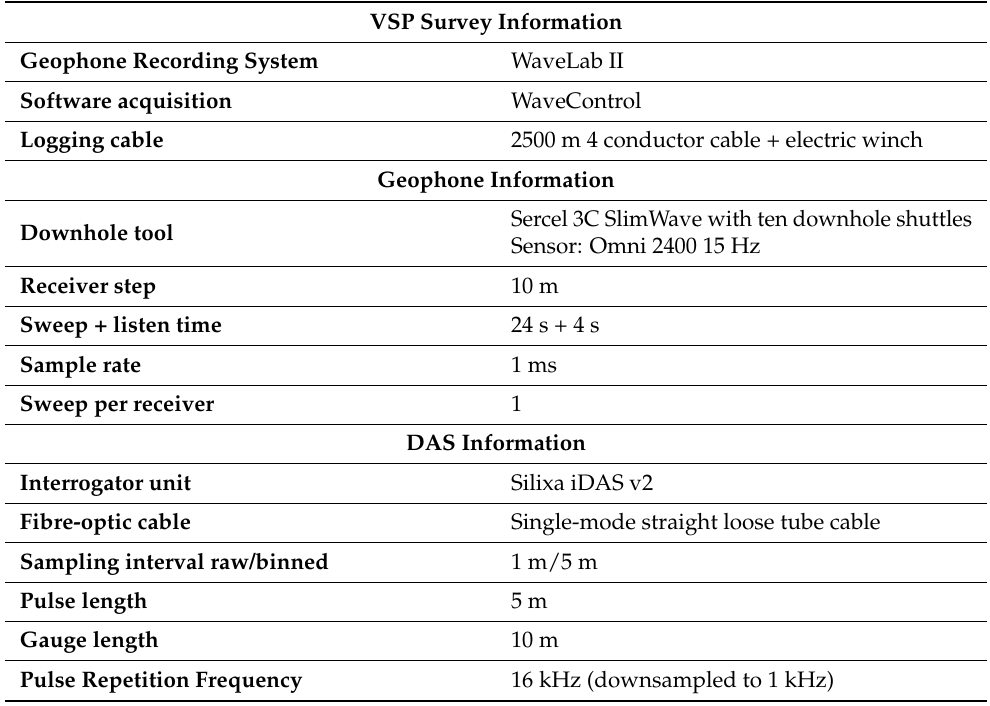
Table 1. Seismic acquisition